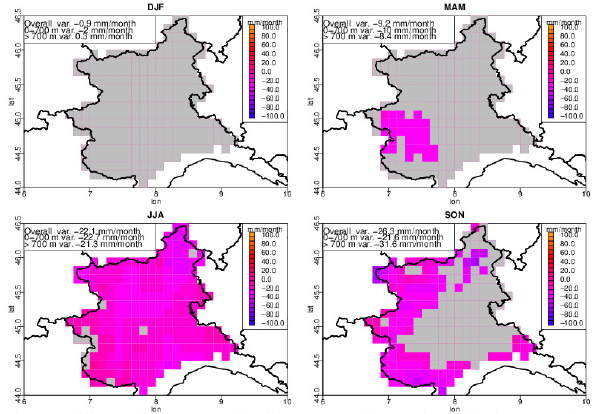
Figure 11: difference between the Multimodel SuperEnsemble scenario precipitation averaged over the period 2031-2050 with respect to the period 1981-2000, as a function of the season (T-test conf. Fig. 11. Difference between the multimodel superensemble sce- level 95%) in Piemonte region. In the upper left boxes overall averages over significant points and altitude bands averages are shown. nario precipitation averaged over the period 2031–2050 with respect to the period 1981–2000, as a function of the season ( T test conf. level 95%) in Piemonte region. In the upper left boxes overall aver- ages over significant points and altitude bands averages are